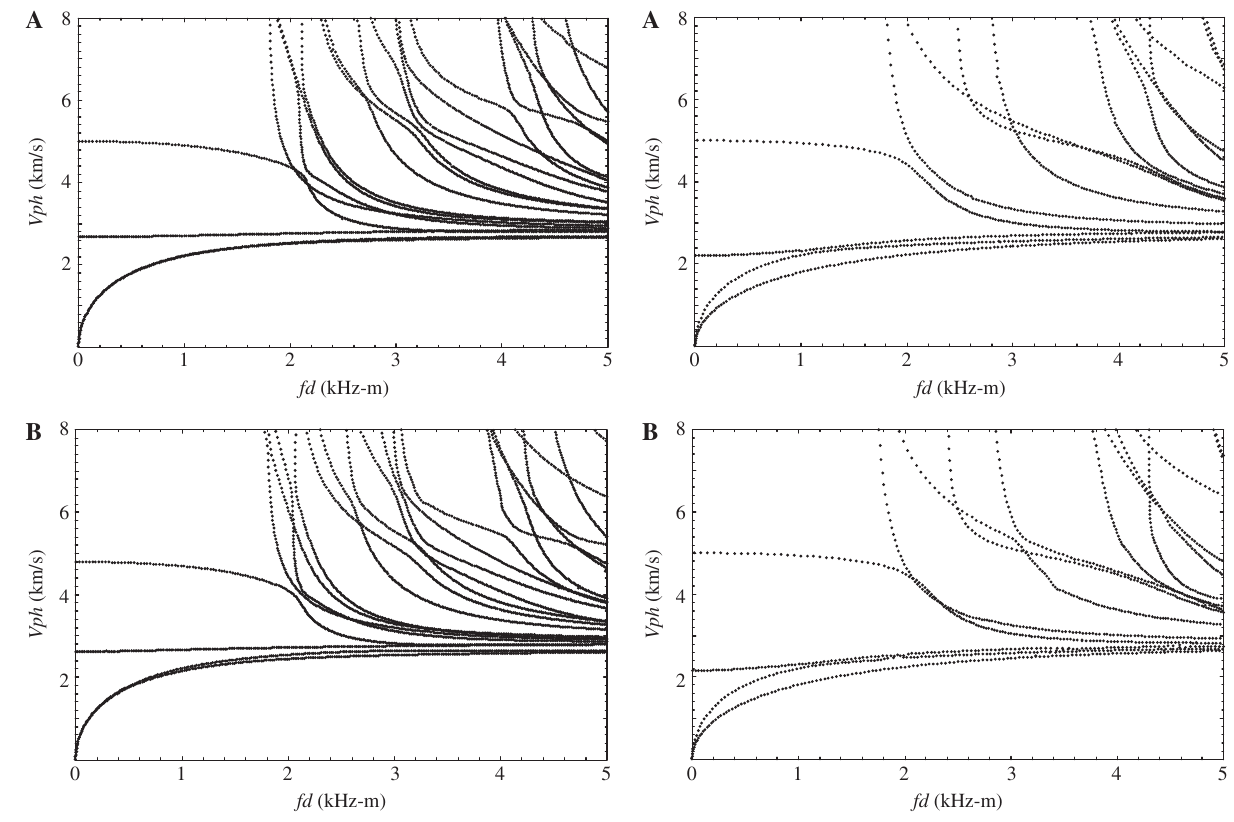
Figure 3: Phase velocity dispersion curves for two z -directional FGPP square bars: (A) linearly graded bar and (B) cubically graded bar.